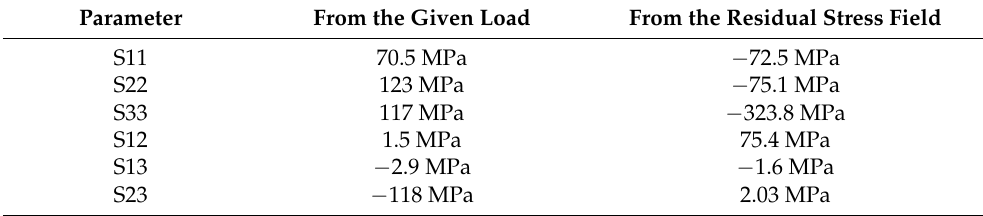
Figure 15. The Von Mises stress distribution of the crankshaft (under the given load). Table 4. Stress components of the maximum stress point from different sources.